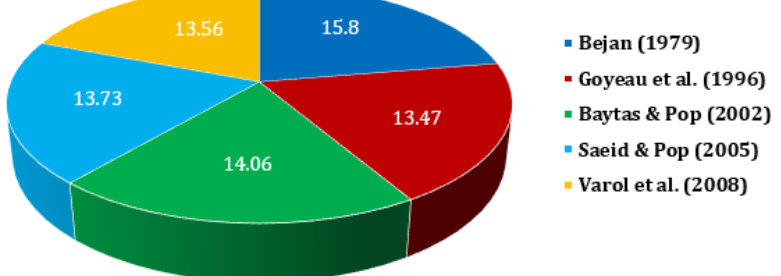
Figure 7. Variation of Nu avg with different Ra for A = 40 [186,279–284].